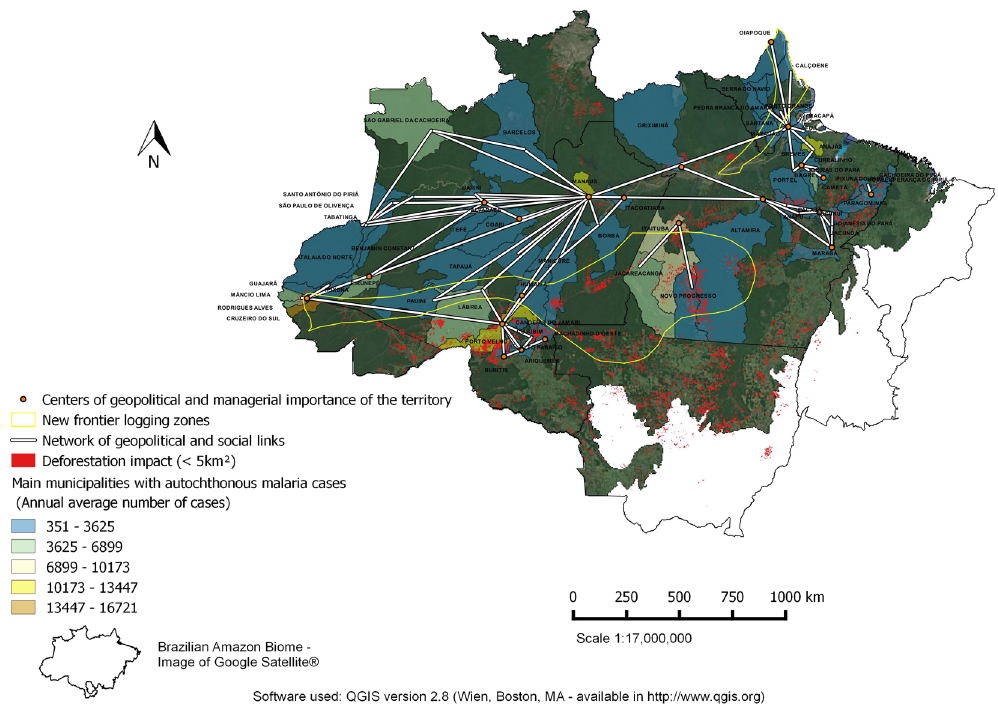
Figure 6. Map of the principal municipalities with autochthonous malaria cases (2009–2015), their network of geopolitical and social links, within the Brazilian Amazonian